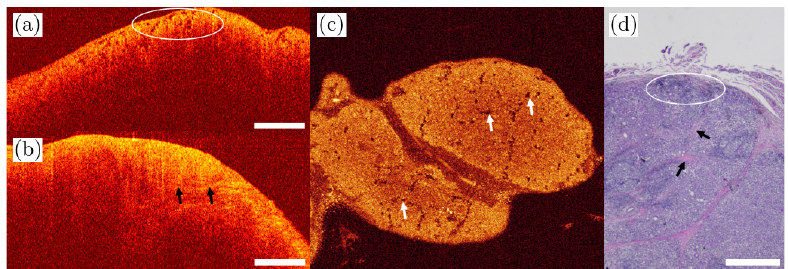
Fig. 12. Images of submandibular gland tissue. Cross-sectional OCT images [panels (a) and (b)] and its en - face OCT image [panel (c)] showing submandibular gland in°ammation. (d) The corresponding histopathological image.